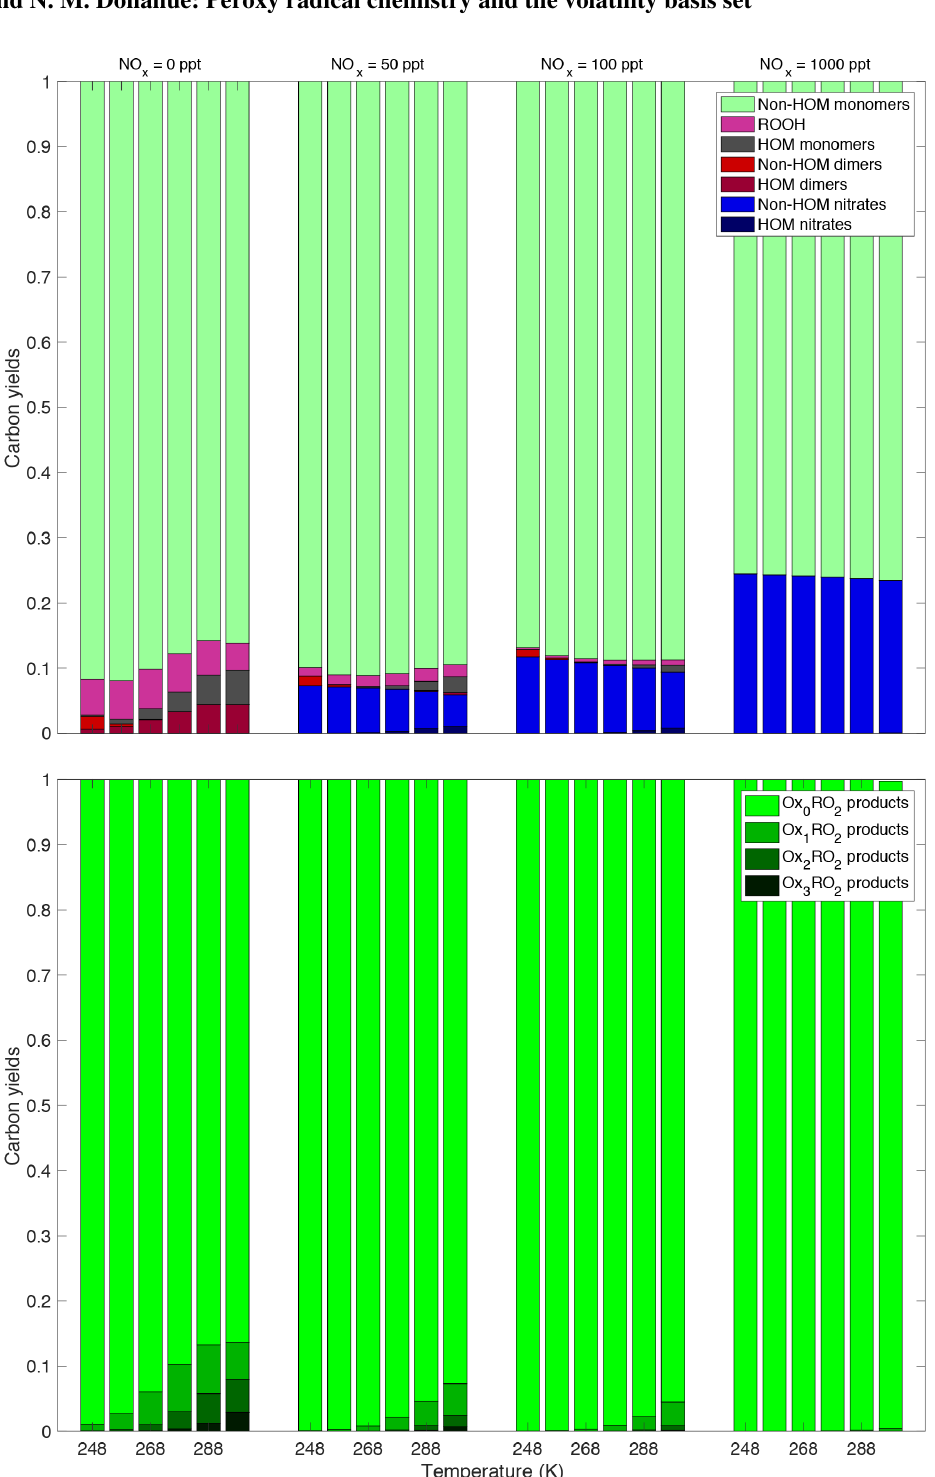
Figure 10. This plot shows the synergistic effect of the NO x and temperature on the product yields. The same trend persists at every NO x concentration, specifically the decrease in the amount of HOMs – both monomers and dimers with decreasing temperature. Of note is that at the highest NO x concentration shown here (1000ppt NO added), the HOM production is close to 0 at every temperature. Thus complete suppression of HOMs occurs around this NO x concentration. This plot shows both the temperature dependence and the NO x dependence again, but colors are based on how oxidized the peroxy radical that produced the products was. The products represented by the darker colors underwent more autoxidation before terminating than those represented by the lighter colors. We can see that autoxidation is suppressed both by temperature and by NO x . Once again, we see that at a high enough NO x concentration autoxidation is effectively suppressed at all the temperatures investigated